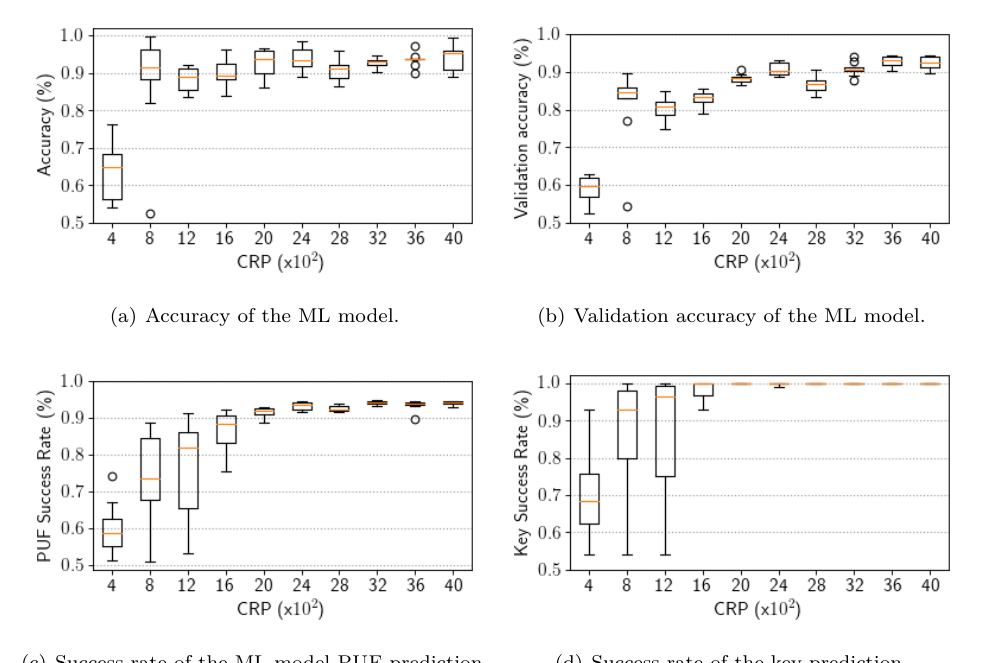
Figure 4: Evaluation of the attack idea using a repetition code with n = 7, Arbiter PUF model with 128 bit challenge, and a Siamese neural network. For every number of CRP s ten neural networks were trained and evaluated.